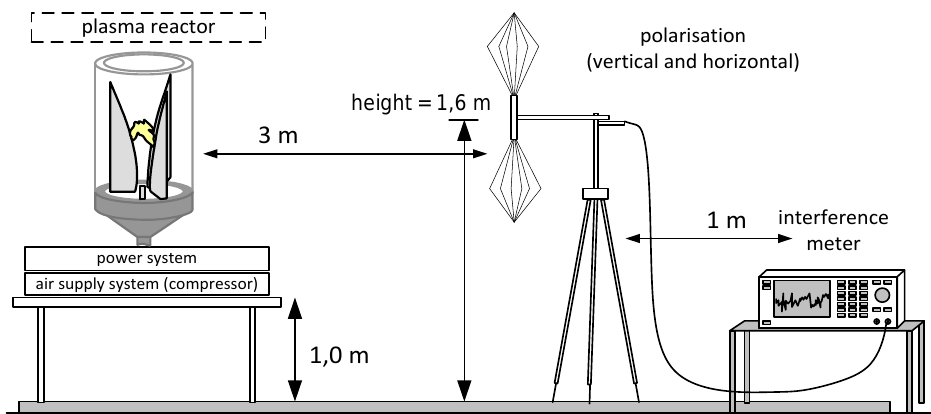
Figure 3. Measuring system for testing radiated emissions.